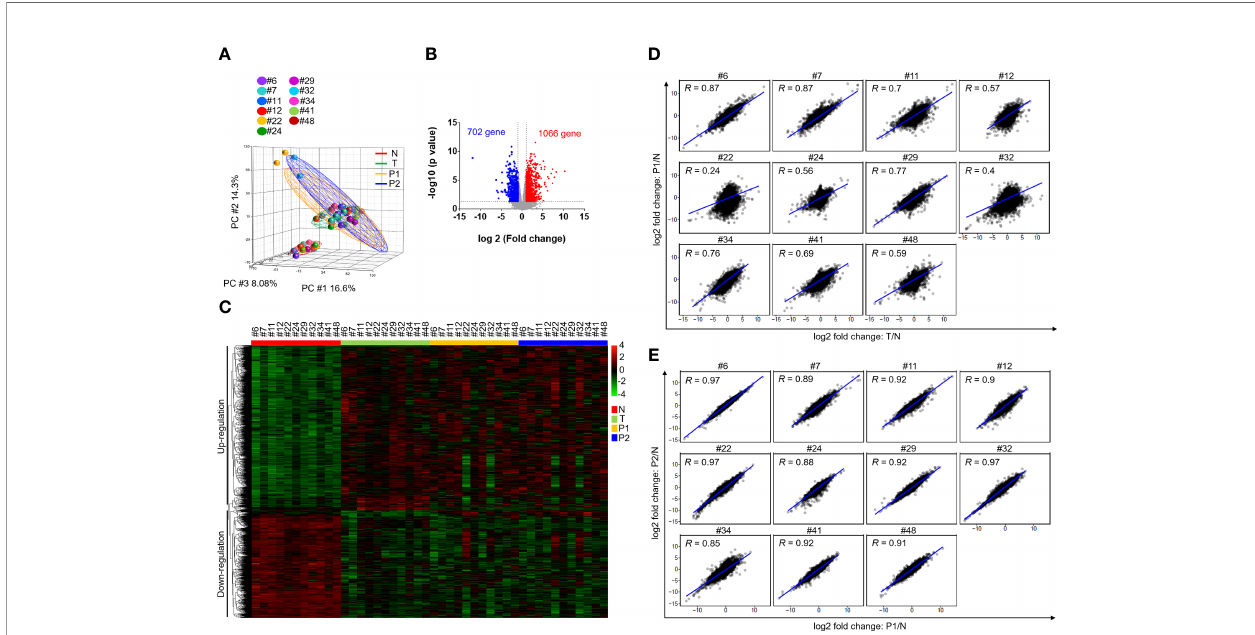
FIGURE 5 | Comparison of transcriptome pro fi les in OSCC patients and PDXs. The transcriptome pro fi les of paired normal tissues, tumor tissues, and xenografts were determined by RNA-seq. (A) Principal component analysis of the adjacent normal tissues (N), tumor tissues (T) and their matched PDXs at passage 1 (P1) and passage 2 (P2) of OSCC patients. (B) Volcano plot of differentially expressed genes between normal tissues and tumor tissues. The x-axis shows the log2-fold change values, and the y-axis shows the -log10 p values for the differentially expressed genes. (C) Expression heatmap analysis of transcriptome datasets from the adjacent normal tissues (N), tumor tissues (T) and their matched PDXs at passage 1 (P1) and passage 2 (P2) of OSCC patients. (D) Gene expression in patient tumor tissues or PDXs was normalized to that in patient adjacent normal tissues. Correlation of gene expression between patient primary tumor tissues and P1 PDXs. (E) Correlation of gene expression between P1 and P2 PDXs.